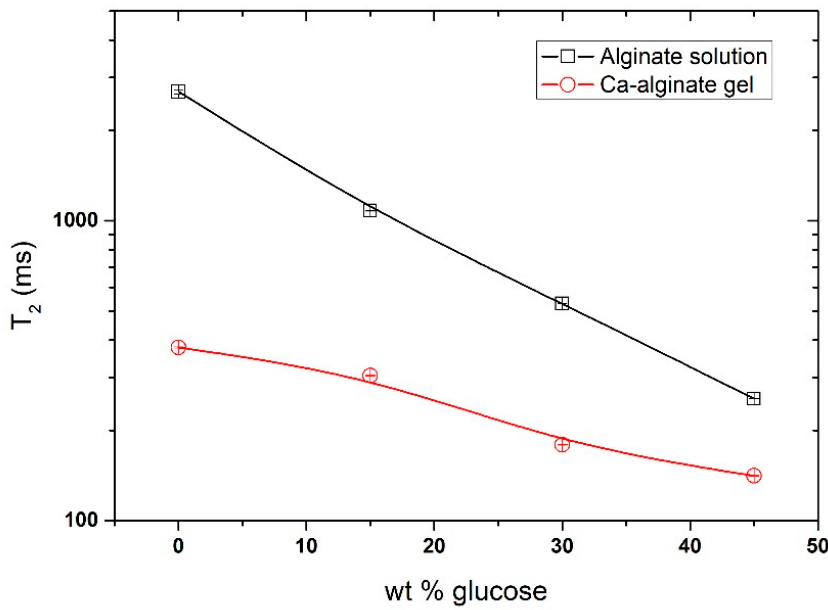
Figure 2. Spin–spin relaxation time for alginate solution and calcium-alginate gel as a function of glucose concentration (0, 15, 30, and 45 wt